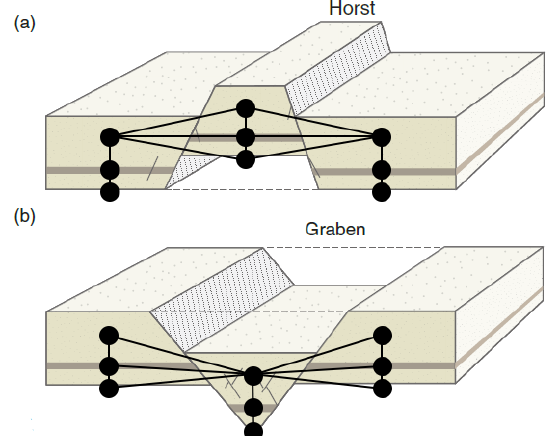
Figure 1. Idealized horst (a) and graben (b) structures with topol- ogy graph overlay, showing the difference in graph structure for different tectonic settings (modified from Fossen, 2010). The black nodes represent the centroids of the geobodies and the black edges the topology connections, together building a topology